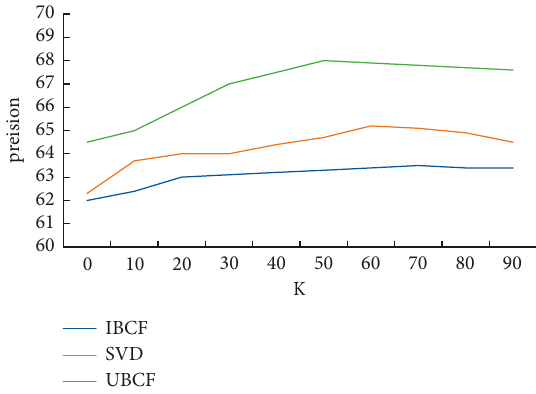
Figure 4: Precision comparison of the 3 ways for the k .